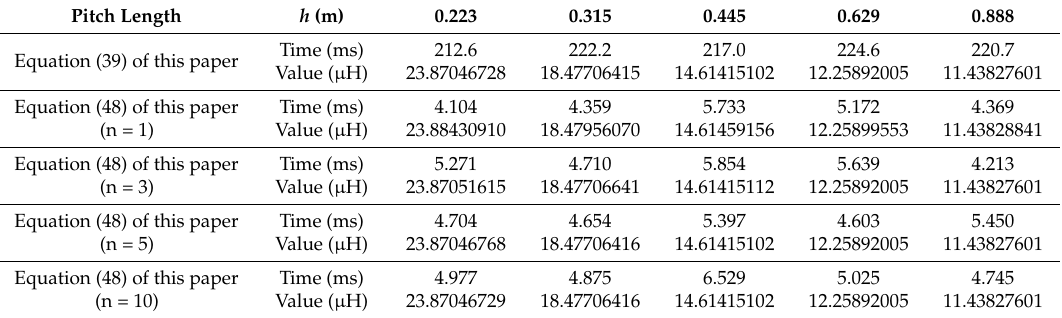
Table 10. Pitch length ( h ) dependence of the time consumption and calculation result between methods of integral and series with different partial sum of the terms.